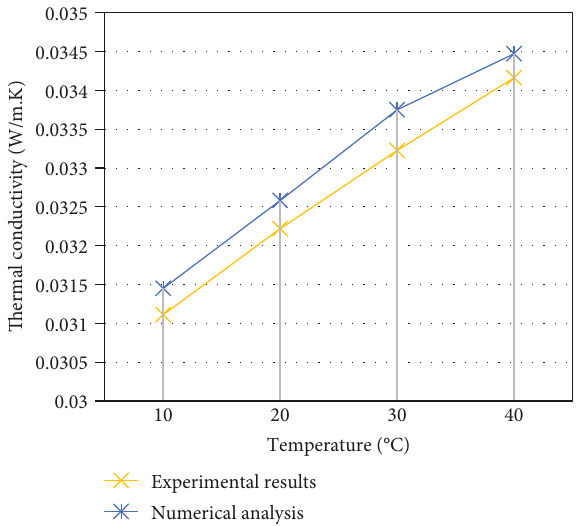
Figure 10: The comparison of the experimental and numerical results for the expanded polystyrene with the density value of 25kg/m 3 .